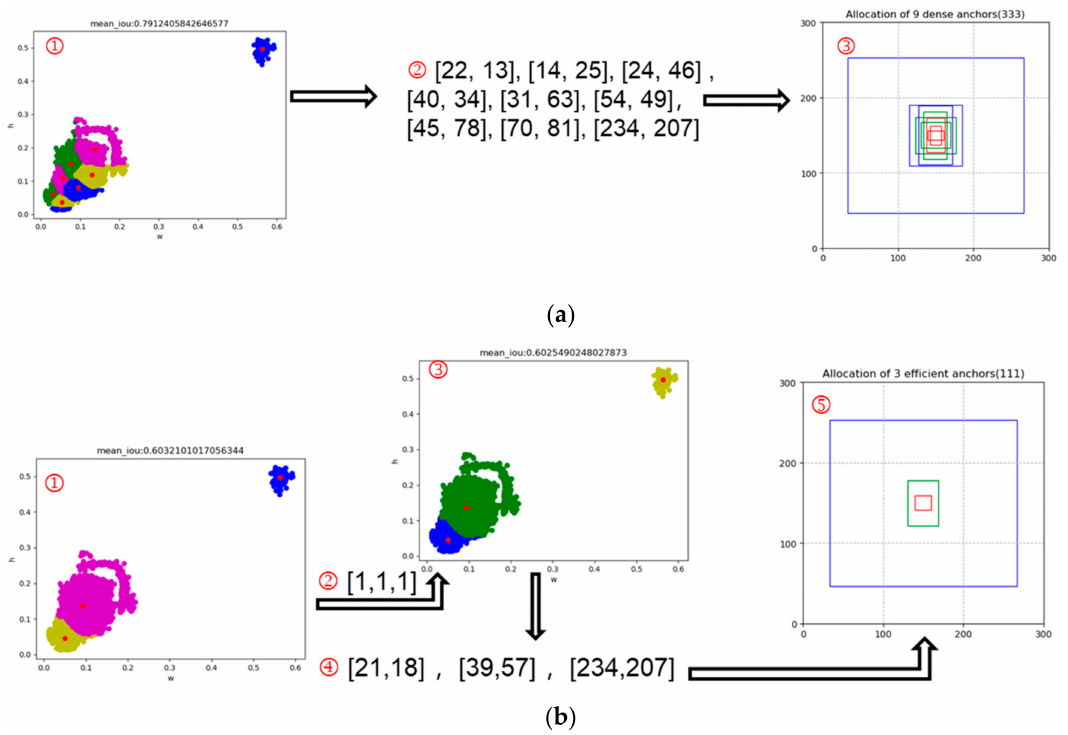
Figure 10. Comparative analysis of the generation and allocation of 9 dense anchors and efficient anchors. ( a ) Generation and allocation of 9 dense anchors in original YOLOv3. ( b ) Generation and allocation of efficient